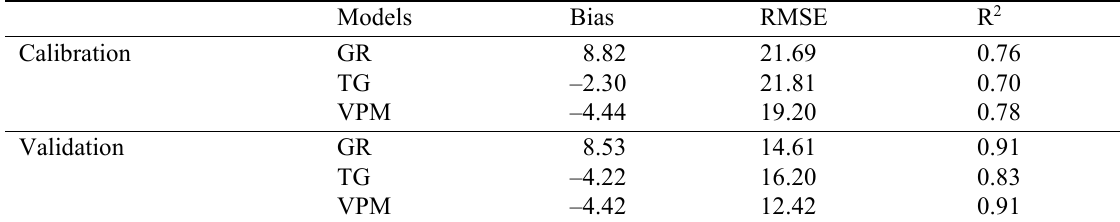
Table 1 Models performances in calibration and